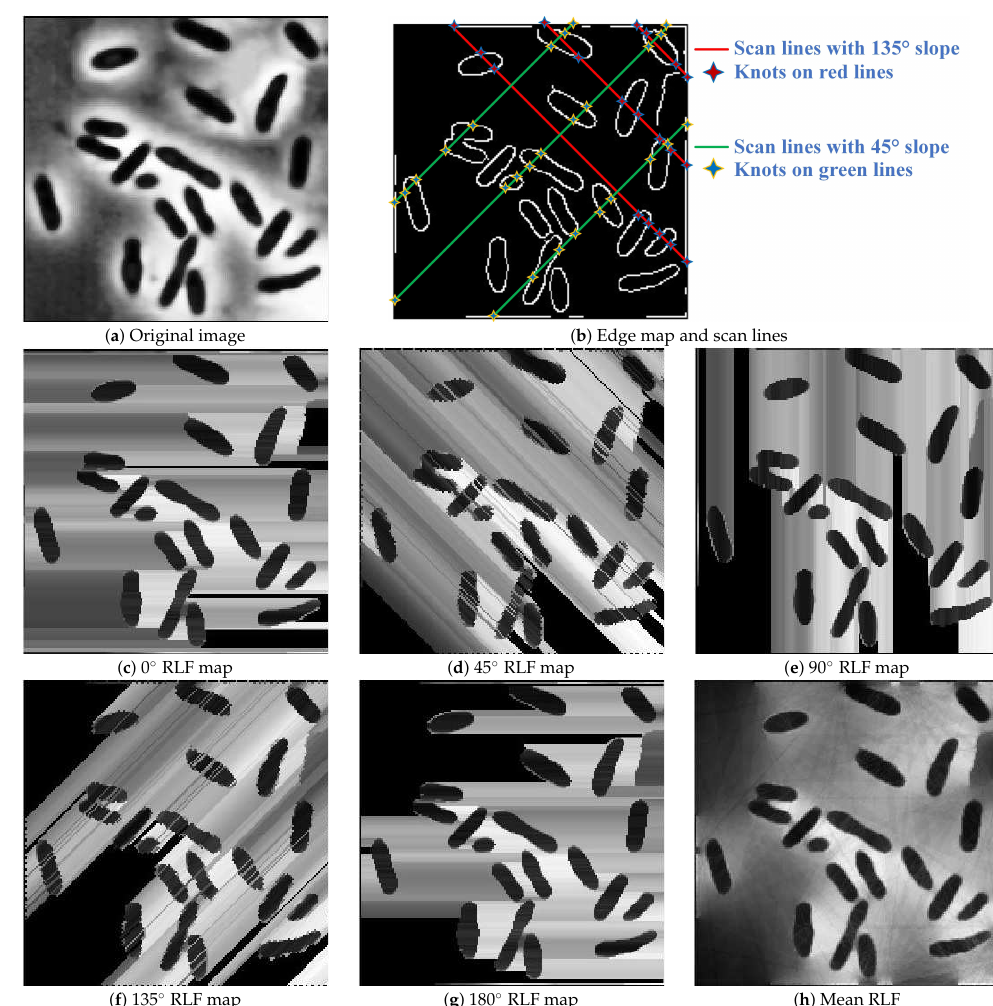
Figure 2. Toy example: illustration of the basic principle of radon-like features (RLF). ( a ) Original bacteria image; ( b ) edge map obtained by using Canny edge detector, this figure also illustrated the line segments and knots; ( c ) 0 ◦ RLF map; ( d ) 45 ◦ RLF map; ( e ) 90 ◦ RLF map; ( f ) 135 ◦ RLF map; ( g ) 180 ◦ RLF map; ( h ) mean RLF map obtained by averaging RLF maps of all